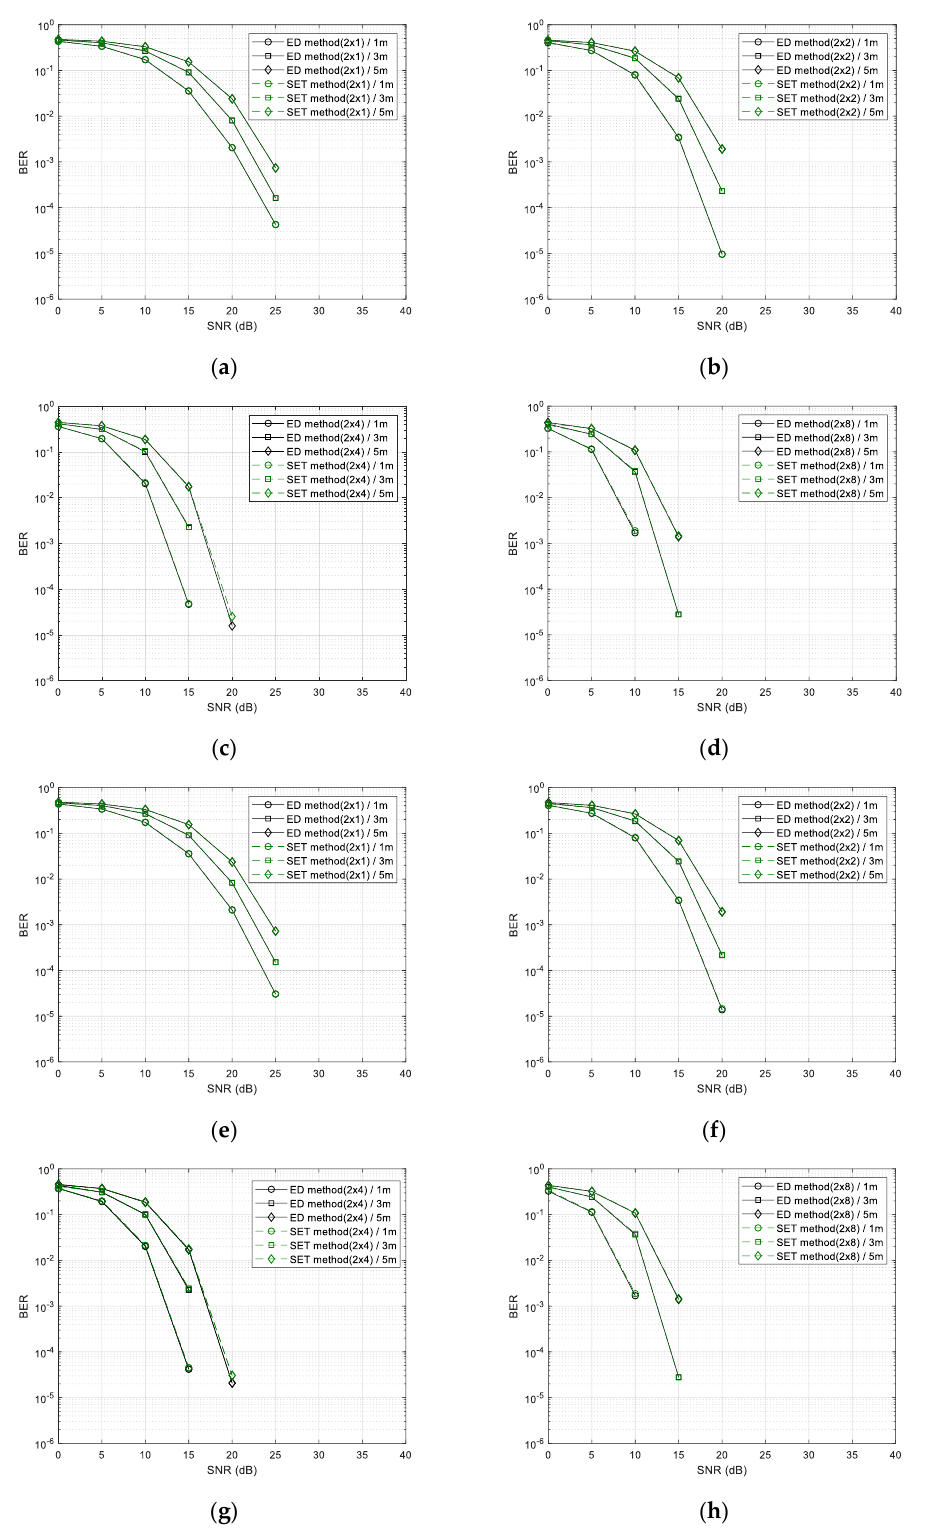
Figure 9. BER performance of SET method for the number of received (Rx) antennas (1, 2, 4, and 8). From ( a ) to ( d ), when adopting the optimal threshold values with increasing the number of Rx antennas from 1 to 8; from ( e ) to ( h ) when adopting threshold values calculated from the estimated RSSI (received signal strength indicator) with increasing the number of Rx antennas from 1 to 8.